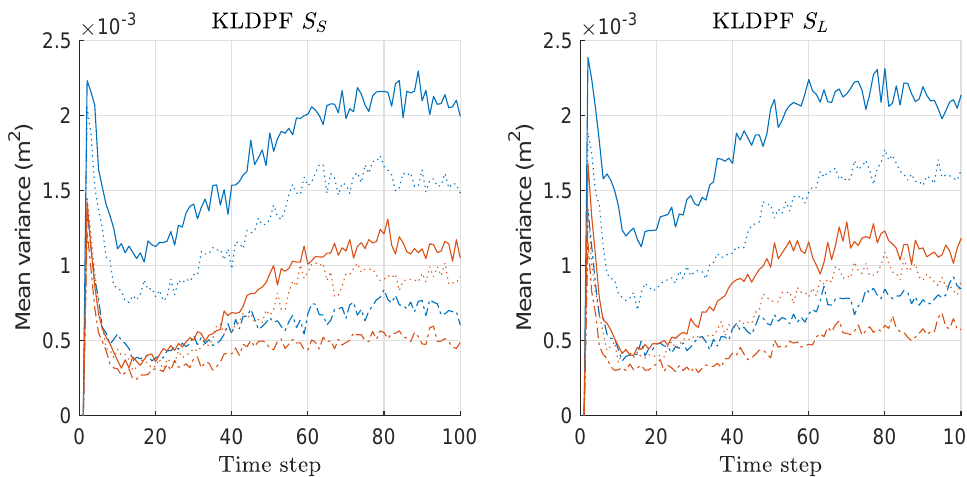
Figure 12. Mean-variance of the weights of particles over 300 runs with 1000 particles for KLDPF and MKLDPF. These results are associated with the results of MDE and mean-risk of Figures 10 and 11. Legend: line style (dash-dot: M = 2; dotted: M = 5; solid: M = 10); (line color: blue: KLDPF; red: